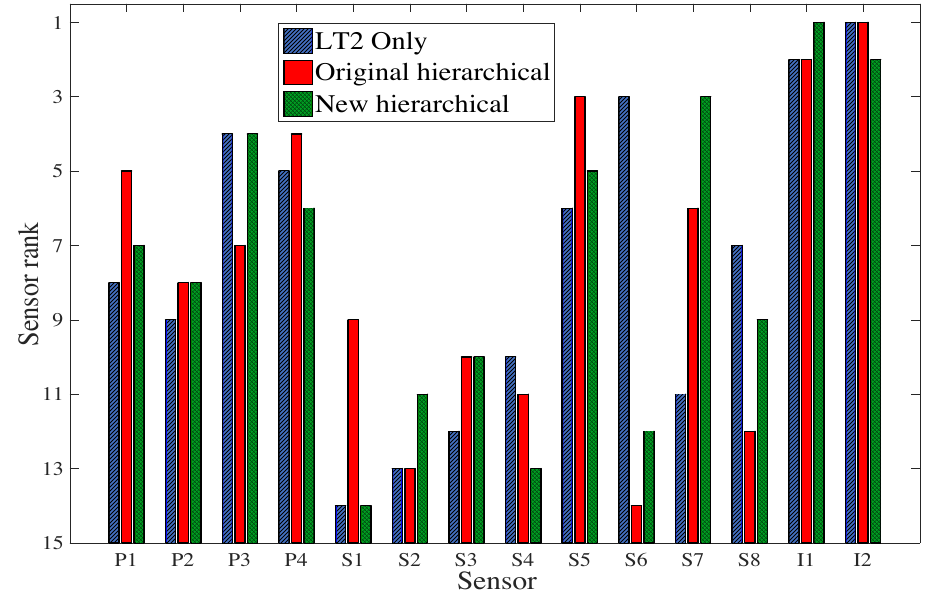
Figure 13. Sensor ranking for the original hierarchical using LT2 independently; the original hierarchical algorithm and the new hierarchical algorithm involving the three load